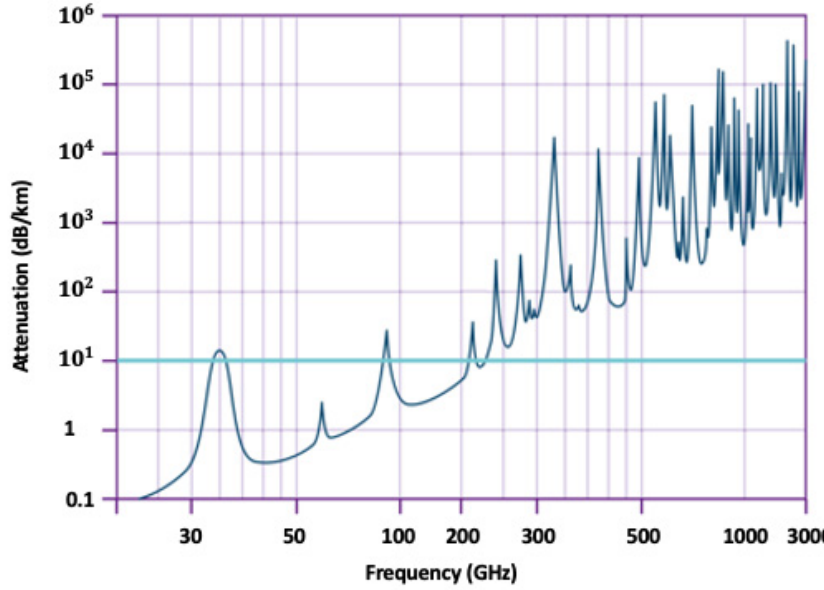
Figure 11. Atmospheric attenuation of radio waves from 30 GHz to 3 THz [130] .